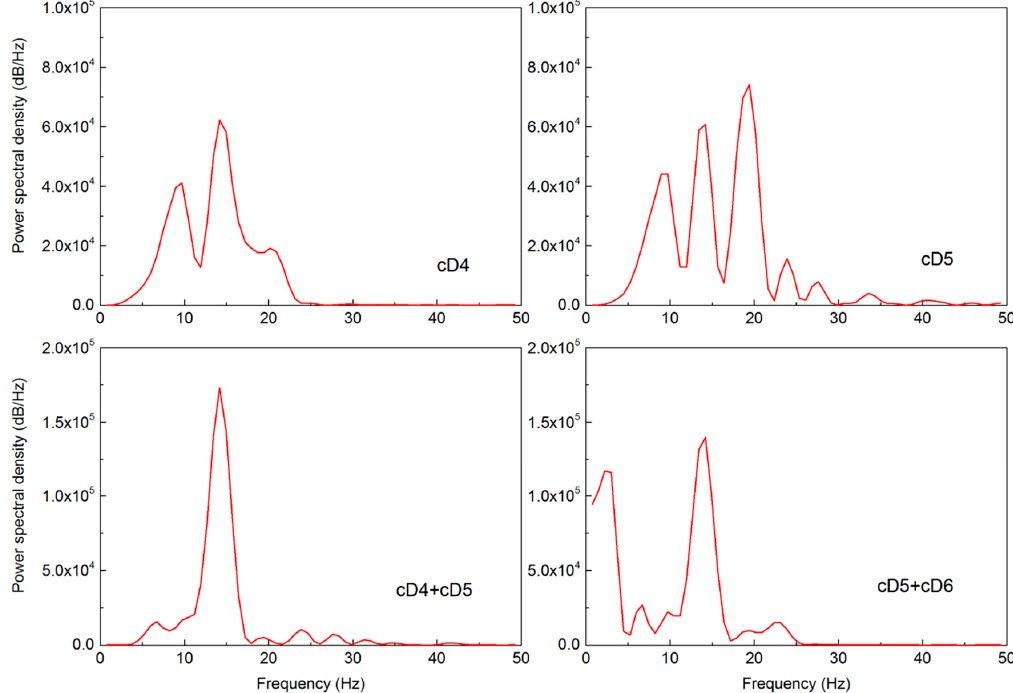
Figure 4. LSP Spectrogram of cD4, cD5, cD4+cD5 and cD5+cD6 after wavelet decomposition. The combination of cD4+cD5 clearly shows only one peak compared to the other coefficients or coefficient combinations.